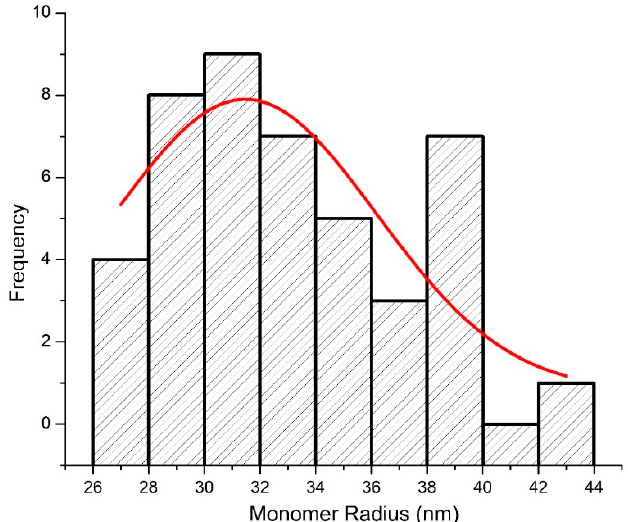
Figure 5. TEM analysis of monomer radius of aggregates generated from biomass burning of olive fuel.